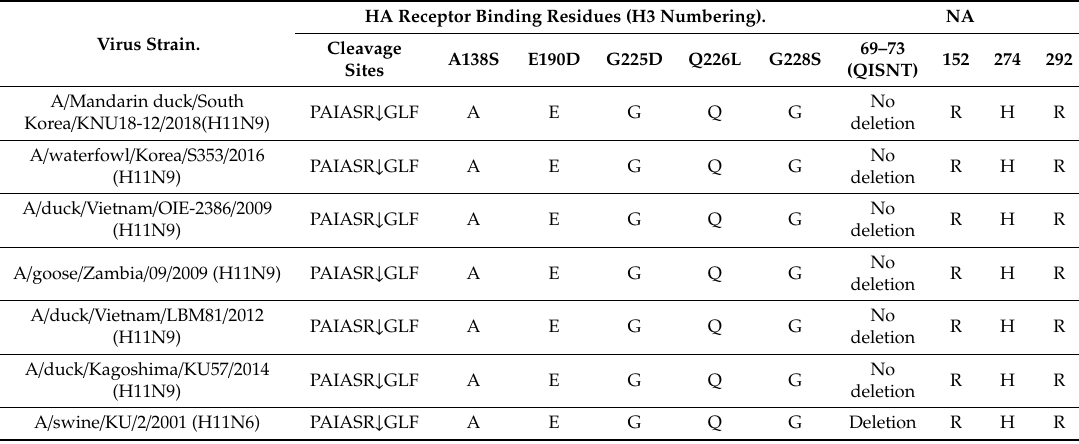
Table 1. Comparison of amino acid in hemagglutinin (HA) receptor-binding site and neuraminidase gene segment of Swine and Avian H11 influenza virus in Korea and near Korea. HA Receptor Binding Residues (H3 Virus Strain.